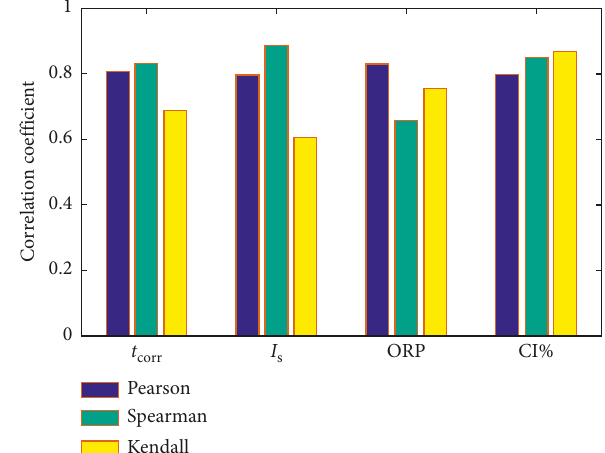
Q235A steel test